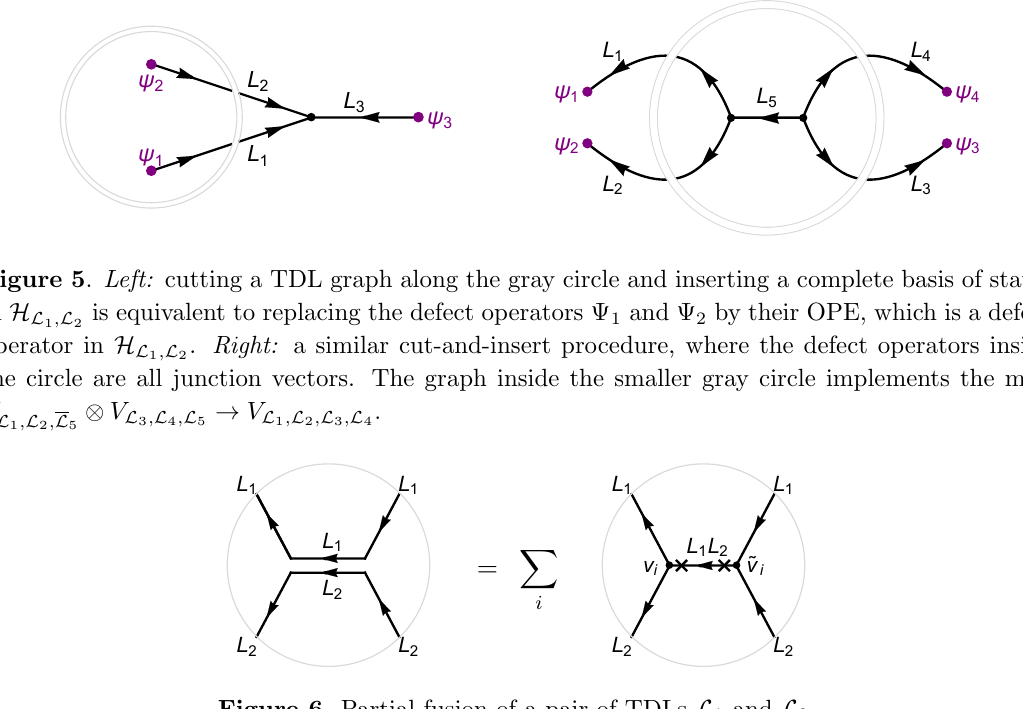
Figure 6 . Partial fusion of a pair of TDLs L 1 and L 2